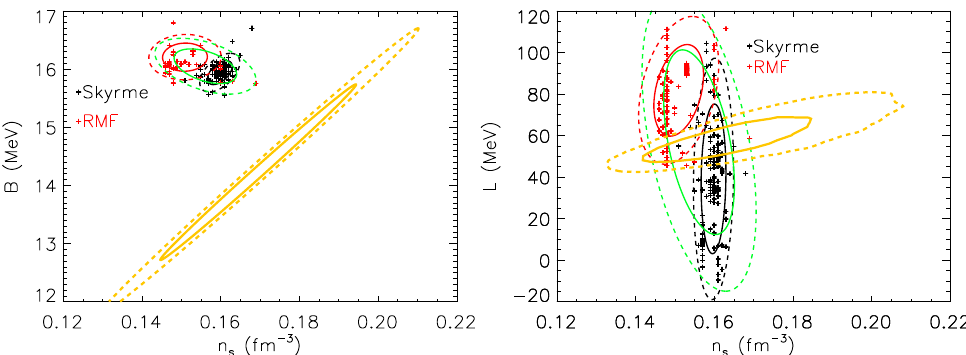
Figure 3. Correlations among symmetric energy parameters of forces in compilations of Refs. [34,36]. The left and right panels show the B − n s and L − n s correlations, respectively. Individual interactions are shown by filled circles. 68.3% and 95% confidence ellipses for Skyrme (RMF) interactions are shown by black (red) solid and dashed ellipses, respectively; green ellipses show the confidence ellipses for the combined force models. 68.3% and 95.5% confidence regions determined from χ EFT calculations of SNM plus PNM (see Section 2.2) are shown by the orange solid and dotted curves, respectively.